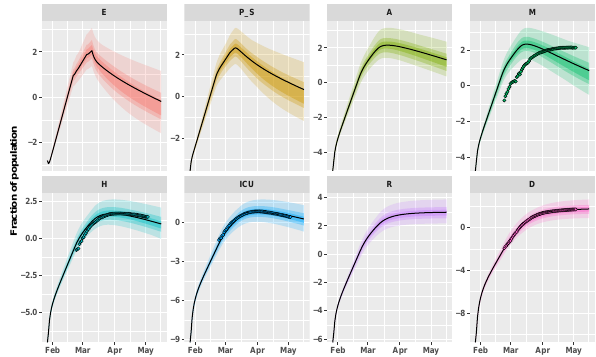
Figure 2. Italy example. Time behavior of state variables when the parameter vector is equal to the final mode vector computed by CRC (black line); dots represent the data available at [21]. Data and simulations are in log-scale, normalized over the whole Italian population ( ∼ 60 million) and multiplied by 10 5 . The colored area reproduces the variation of the temporal behavior when parameters vary between the 60th, 70th, and 90th percentile of their corresponding conditional pdfs (see Supplementary Materials). Time starts from 27 January